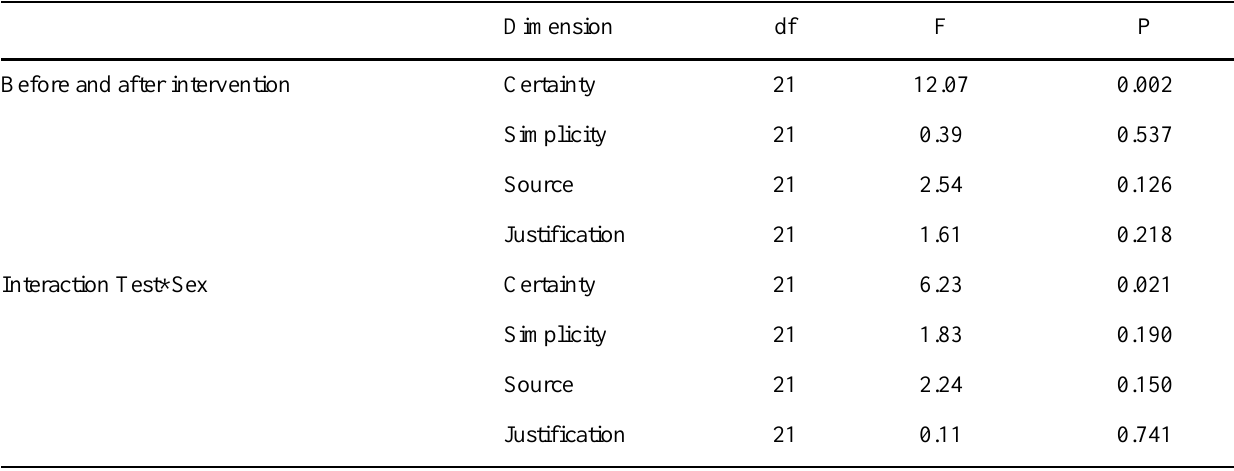
Table 9 . Results of univariate tests for differences in PEBs before and after delivery of the teaching intervention and for interactions between pre- and post-test scores and sex of the students. Dimension df F P Before and after intervention Certainty 21 12.07 0.002 Simplicity 21 0.39 0.537 Source 21 2.54 0.126 Justification 21 1.61 0.218 Interaction Test*Sex Certainty 21 6.23 0.021 Simplicity 21 1.83 0.190 Source 21 2.24 0.150 Justification 21 0.11